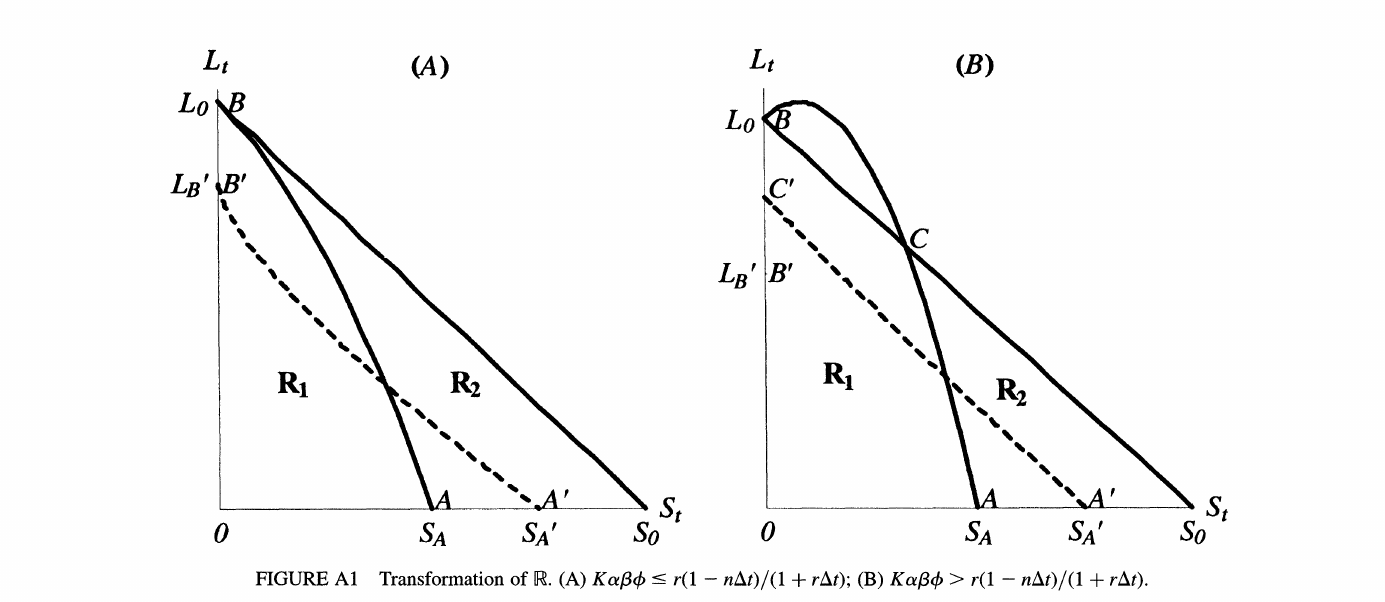
FIGURE A1 Transformation of N. (A) Kcq3b -<